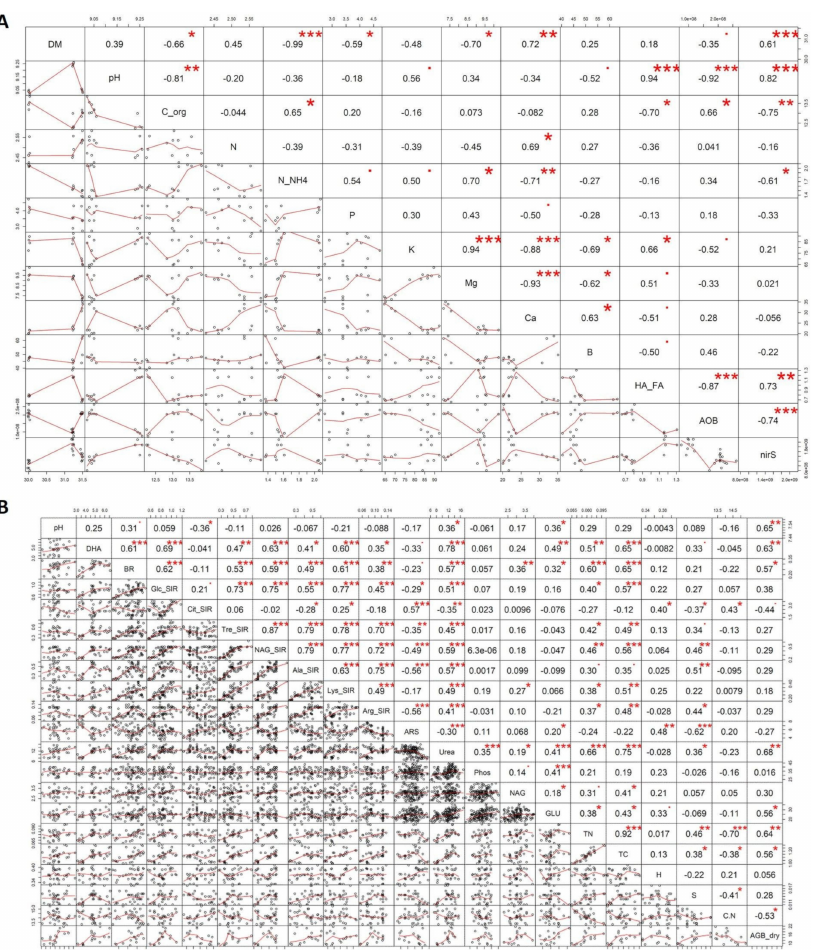
Figure 2. The Pearson’s correlation matrix of the maturated manure properties ( A ), soil, and plant properties ( B ). Explanation: . Significant at 0.10 level; * Significant at 0.05 level; ** Significant at 0.01 level; *** Significant at 0.001 level.